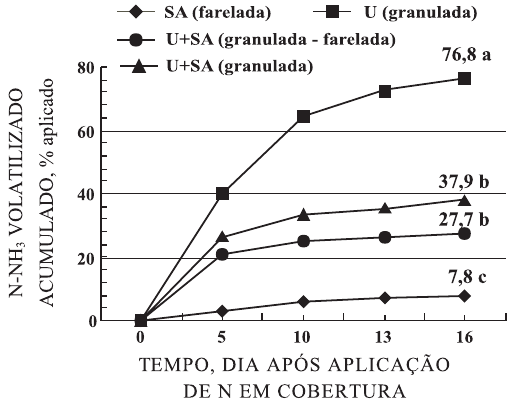
Figura 2. Perdas de N-NH volatilizado acumulado 3 de algumas das misturas de grânulos utilizadas em cobertura nitrogenada na cultura de milho, safra 2004-2005, Uberlândia (MG). Entre as misturas, na quarta coleta, as médias seguidas de letras diferentes diferem entre si pelo teste de t (Student), a 5 %. CV = 24,7